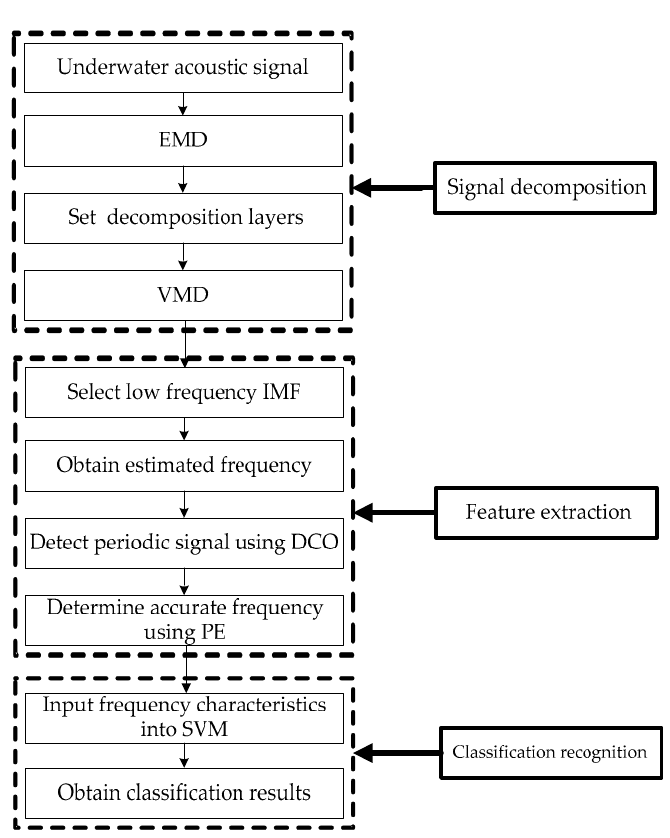
Figure 2. The flow chart of a fusion frequency feature extraction method.